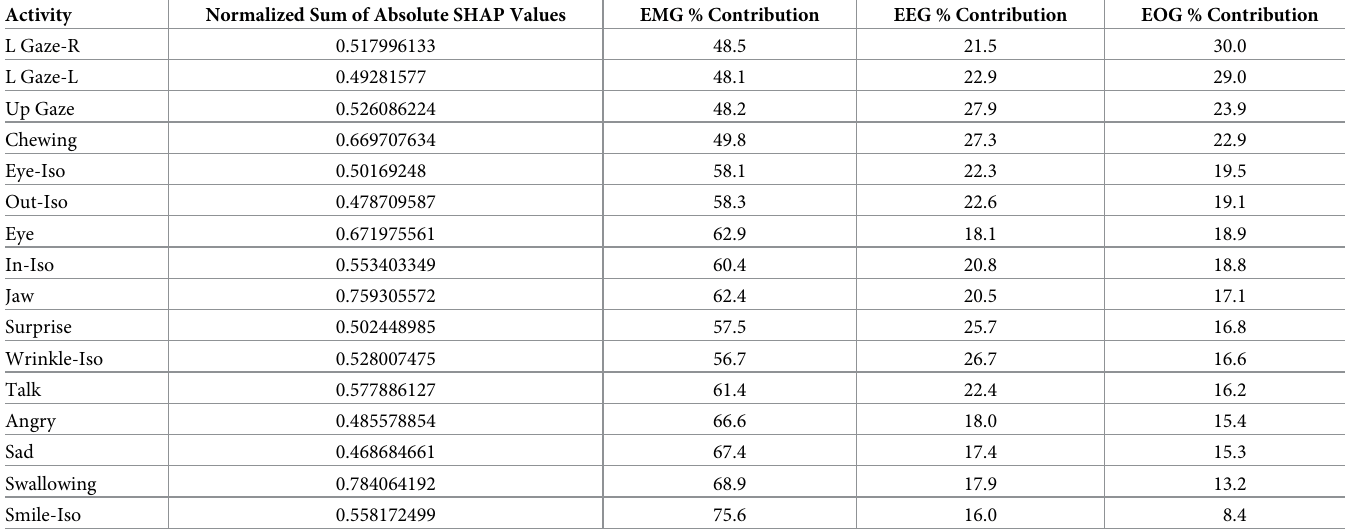
Table 2. Table of the 16 mock-PerfO activities and how EMG, EEG, and EOG feature groups contribute to classification accuracy. Activity Normalized Sum of Absolute SHAP